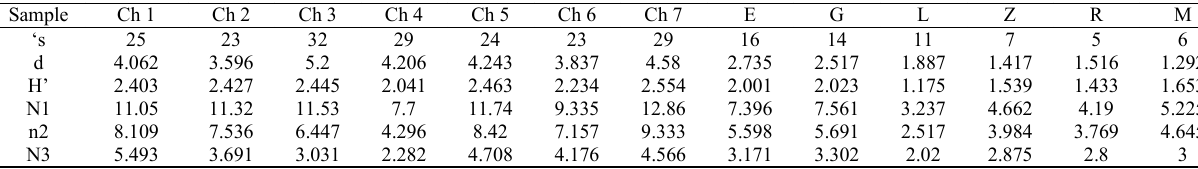
Table 2. Diversity Index and ecological parameters obtained for each sampling site of Chacmochuch lagoon System. (Ch1-Ch7 sites of Chacmochuch bay; E, G, L, Z, R and M are sites of the system, name’s abbreviations are defined in Table 1). ‘s=richness, d=diversity, H’=Shannon-Wiener index, N1=number of species of fish with average abundance, n2=number of very abundant species, N3=number of rare